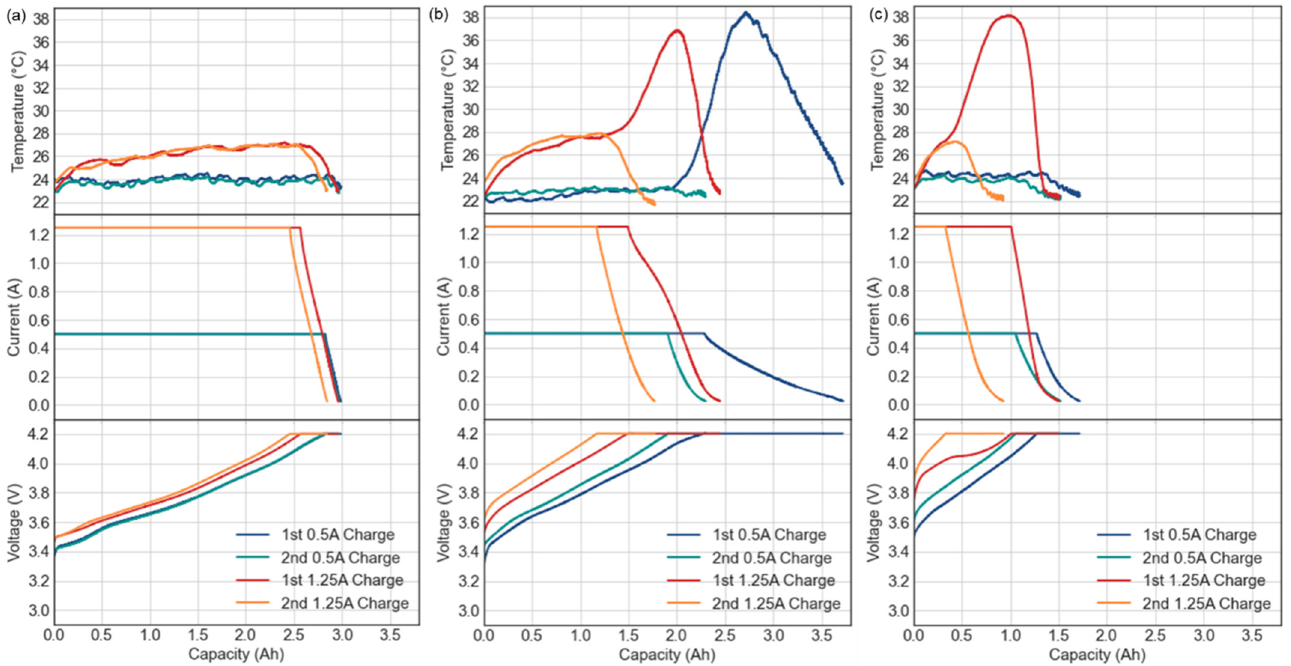
Figure 1. Representative charging profiles of new and used cells during screening cycles (two 0.5 A cycles and two following 1.25 A cycles between 3.0 V and 4.2 V). ( a ) New cell without ECTR. ( b ) Used cell with ECTR triggered at low rate (0.5 A) and high rate (1.25 A). ( c ) Used cell with ECTR triggered at only at high rate (1.25 A).